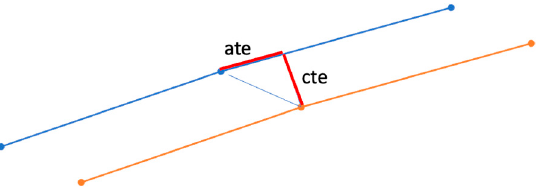
Figure 19. The cross-track error ( cte ) and the along-track error ( ate ) between two trajectories. The cte and the ate are computed for every point of the tracklet. The cte and the ate errors for the whole tracklet are computed as the means of the individual point errors.